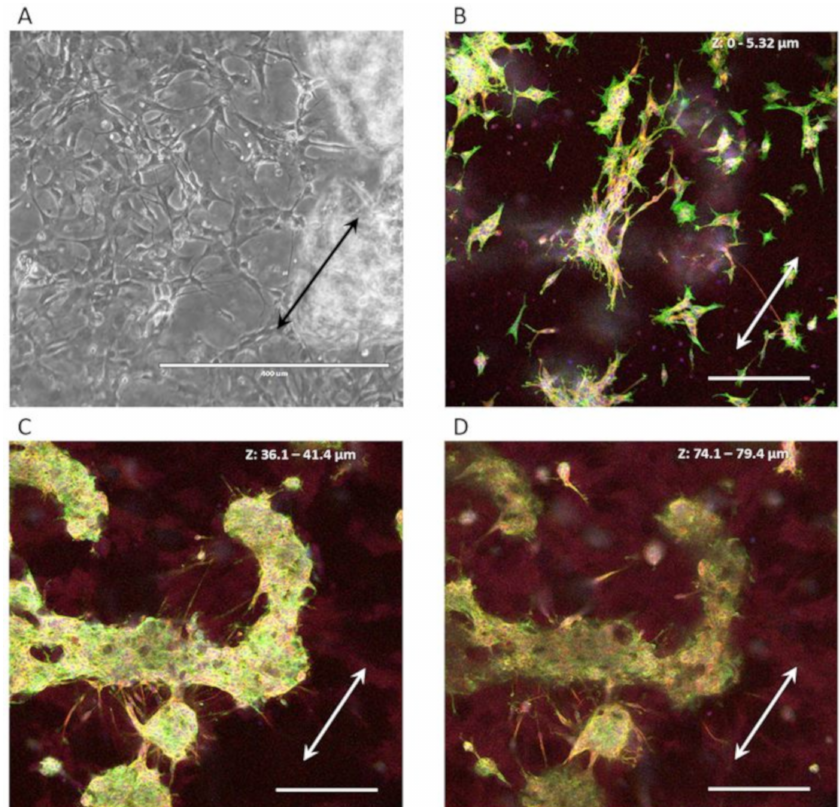
Figure 4. Aligned 3D SH-SY5Y cell cultures on nanogrooved substrates. ( A ) SH-SY5Y cells at 11 days in vitro (DIV) showing di ff erentiation into the neuronal lineage during the experiment, as seen from the neuronal outgrowths. Cells show a qualitative preference to outgrowth direction along the nanogrooves (direction of the double-headed arrows). Blurry areas in the image indicate “clusters” of cells that have migrated into the 3D hydrogel away from their original position on the nanogrooved substrate. The scale bar denotes 400 µ m. ( B – D ) Maximum intensity projections of subsections of slices from a z-stack showing the extent of SH-SY5Y cells and their outgrowths throughout the 3D cell culture. Qualitatively, cell bodies and outgrowths can be observed to align to the nanogrooved substrate at close range ( B ), with the e ff ect decreasing as the distance to the substrate increases ( C , D ). The white, double-sided arrows denote the orientation of the nanogrooves. Scale bars denote 200 µ m. Immunofluorescence staining shows neuron-specific staining for β -Tubulin III in red, F-actin in green and cell nuclei in